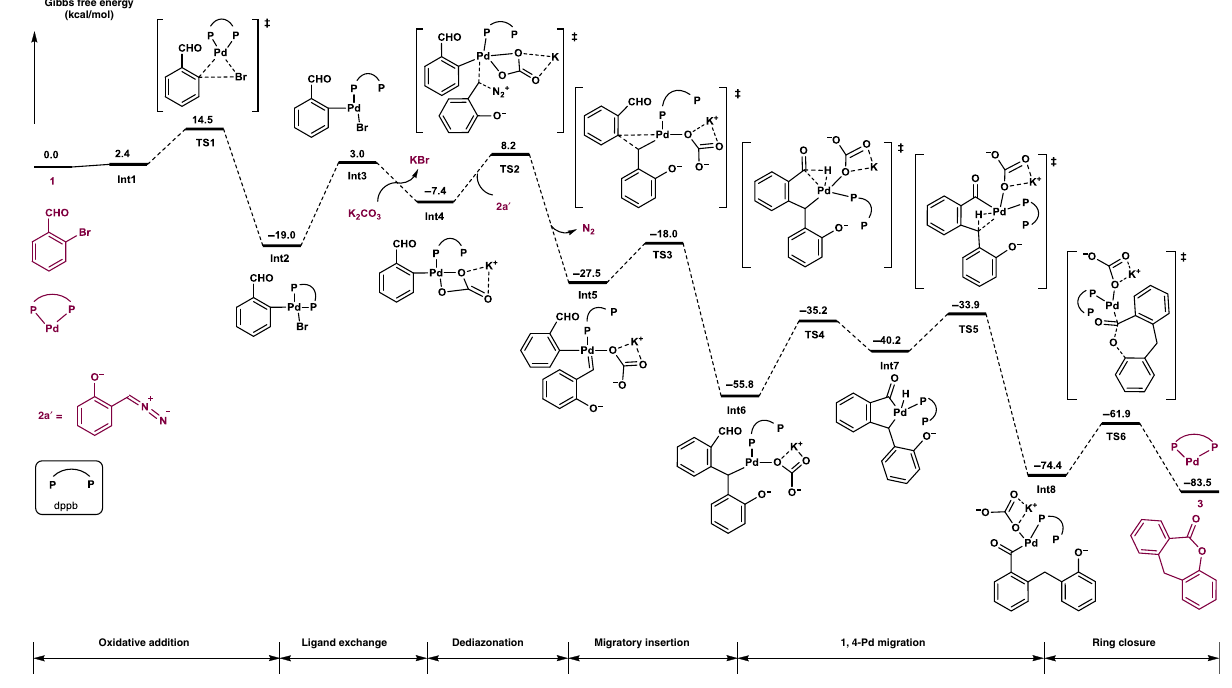
Fig. 3 DFT calculations. Reaction energy pro fi les calculated at M06/def2-TZVP//B3LYP/6-31G(d)(LANL2DZ) level.